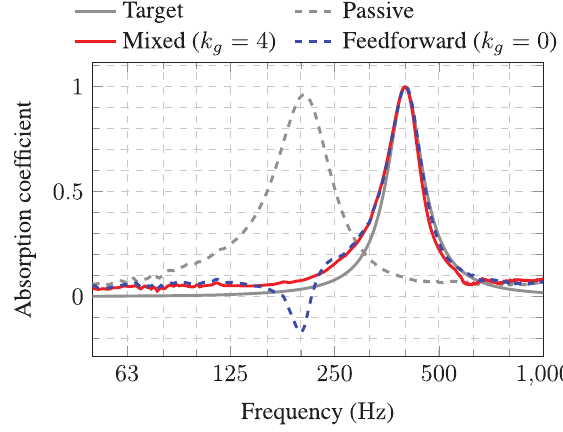
Figure 8. Experimentally obtained absorption coef fi cients for the single-degree-of-freedom absorber, with